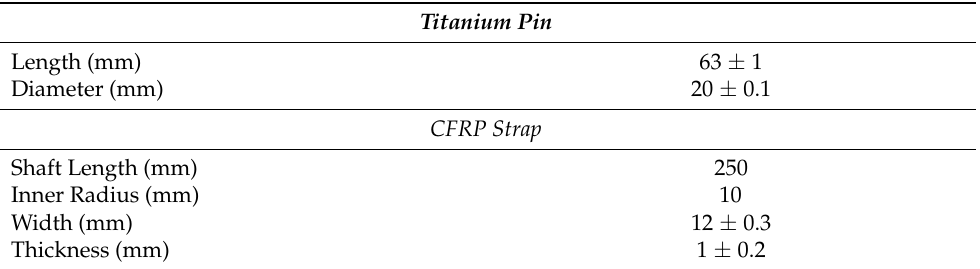
Table 3. Pin and strap dimensions (mm).